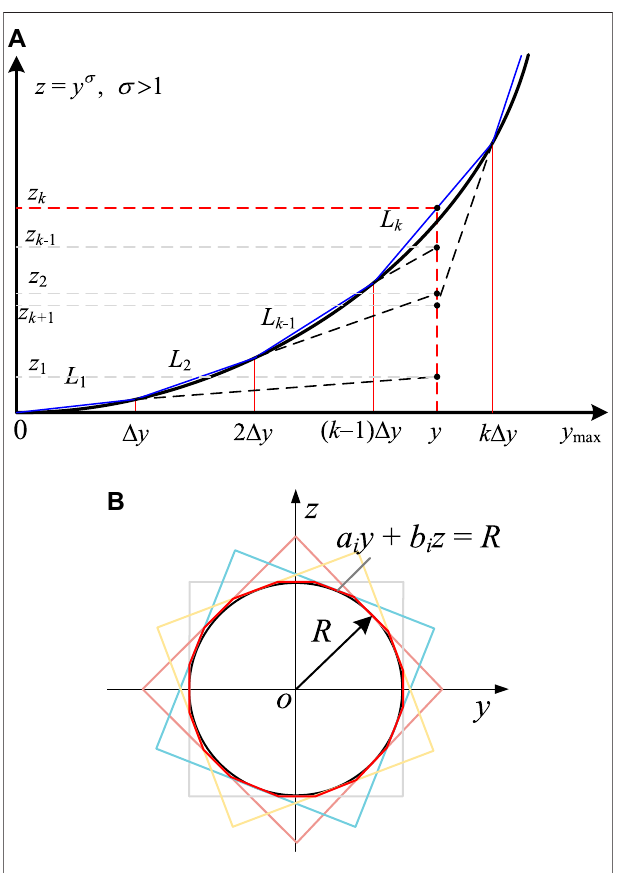
FIGURE2| Piecewiselinearizationforthepowerfunctiontermandcircle term; (A) power function term; and (B) circle term.